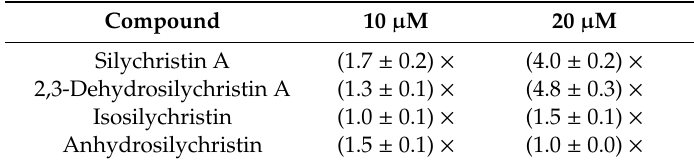
Table 3. Doxorubicin-sensitization rate of doxorubicin-resistant human ovarian carcinoma cells (HOC / ADR) co-cultivated with the presence of silychristin